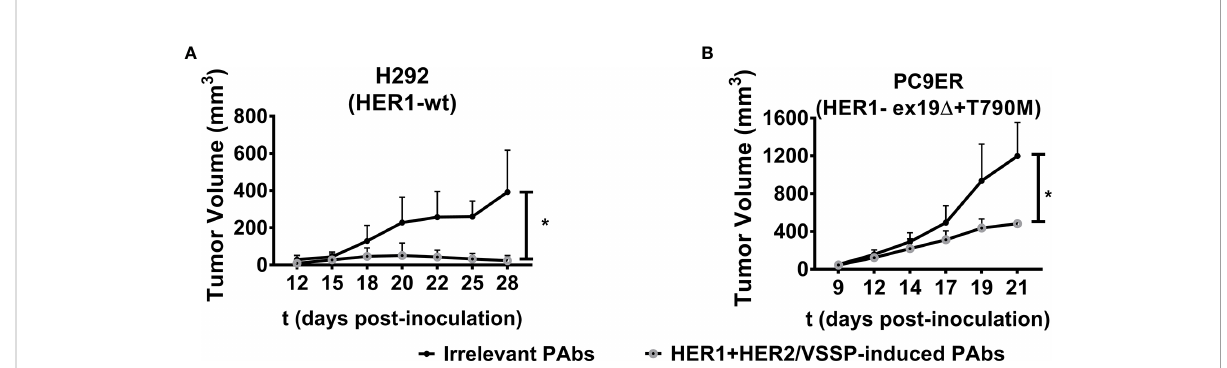
FIGURE 5 Inhibition of tumor growth. H292 (10 6 per mouse) or PC9 cells (3 × 10 6 per mouse) were subcutaneously implanted in the fl anks of Nu/Nu nude mice. When the length and width of the tumors reached 3 × 3 mm, mice were randomized in groups of fi ve animals and treated with irrelevant (from control group, black- fi lled circles) or vaccination-induced PAbs (gray-lined open circles) obtained in rabbits (1 mg of total IgG/mouse/ injection for both treatment groups) every 3 days. Tumor volumes corresponding to the kinetic growth of (A) H292 and (B) PC9ER tumors are shown. Data are means ± SD from fi ve mice per group. Statistical analysis of tumor volume kinetics was performed using Mann – Whitney U test. * p <